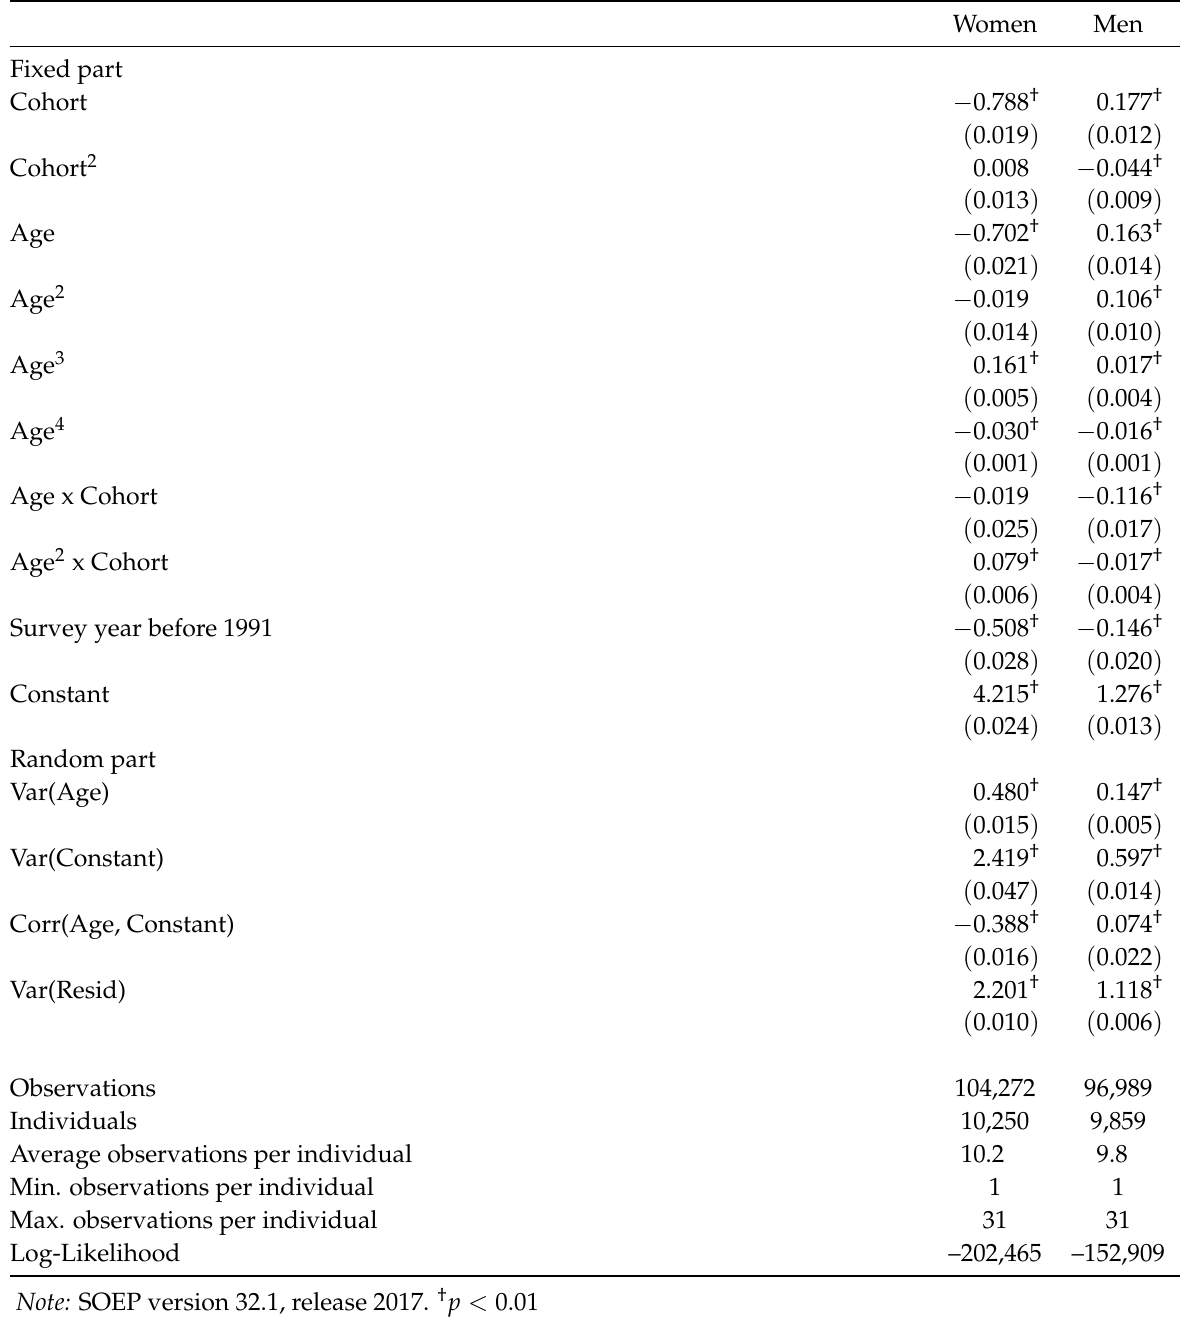
Table 3: Hierarchical linear models for change in housework